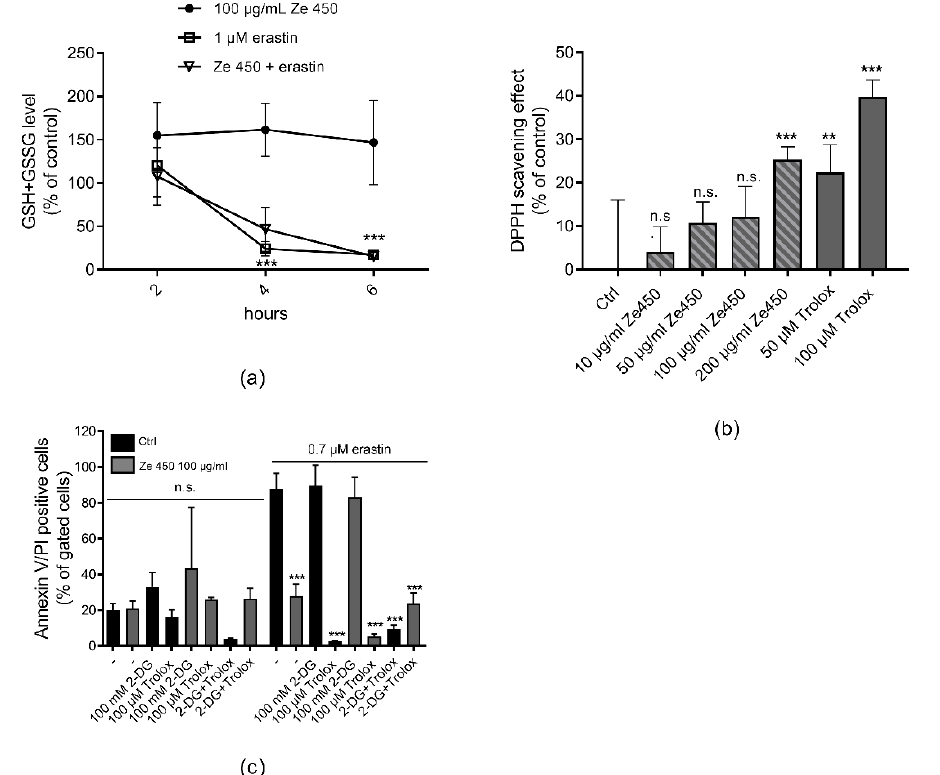
Figure 1. Protective effects of Ze 450 are independent of its antioxidant properties. ( a ) Effects of Ze 450 on cellular glutathione levels ( n = 5–7/treatment condition). Data are shown as mean + SD (*** p < 0.001 compared to untreated control; ANOVA, Scheff é ’s test). ( b ) DPPH radical scavenging activity was determined at 517 nm. (*** p < 0.001, ** p < 0.01 compared to control; ANOVA Scheff é ’s test; n.s. not statistically significant). ( c ) Cell death was assessed by flow cytometry using Annexin V and PI after 16 h of treatment in HT22 cells. The bar graph shows one representative experiment with three replicates per sample (mean + SD; 5,000 cells per replicate; *** p < 0.001 compared to erastin treated control; ANOVA Scheffé ’ s test).